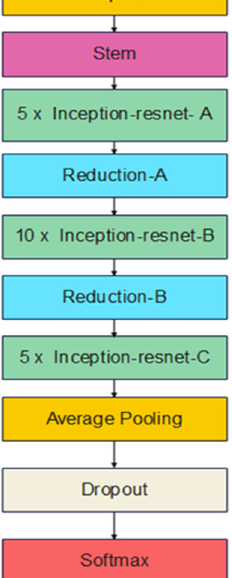
Figure 5. InceptionResNetV2 architecture.